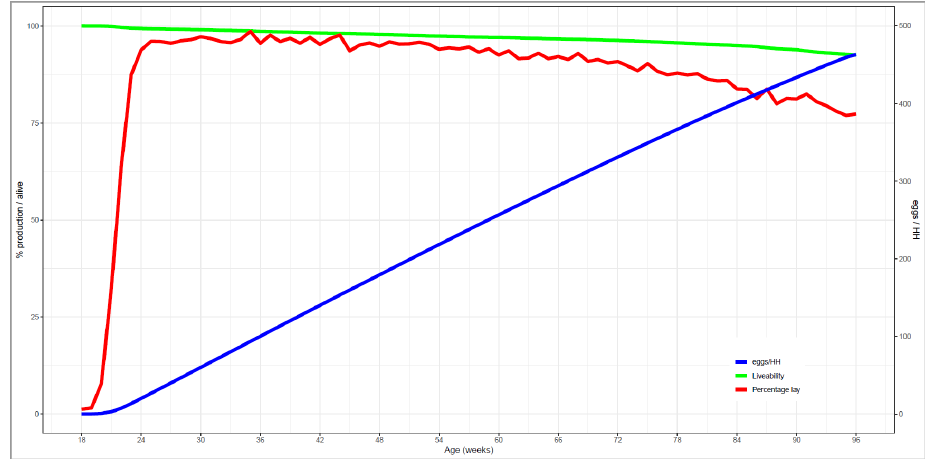
Figure 2. Performance statistics over the whole laying period of the flock. The percentage lay (number of eggs laid per day per live hen, red line, primary y axis), the livability (percentage hens alive, green line, primary y axis), and the eggs per hen housed (blue line, secondary y axis) are shown. The total number of weeks this flock had a percentage of lay above 90% is 49 weeks, and above 95% is 29 weeks and the flock drops below 80% of lay at 93 weeks of age.